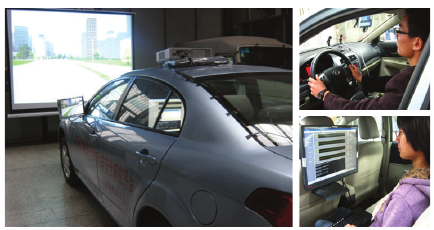
Figure 1: Driving